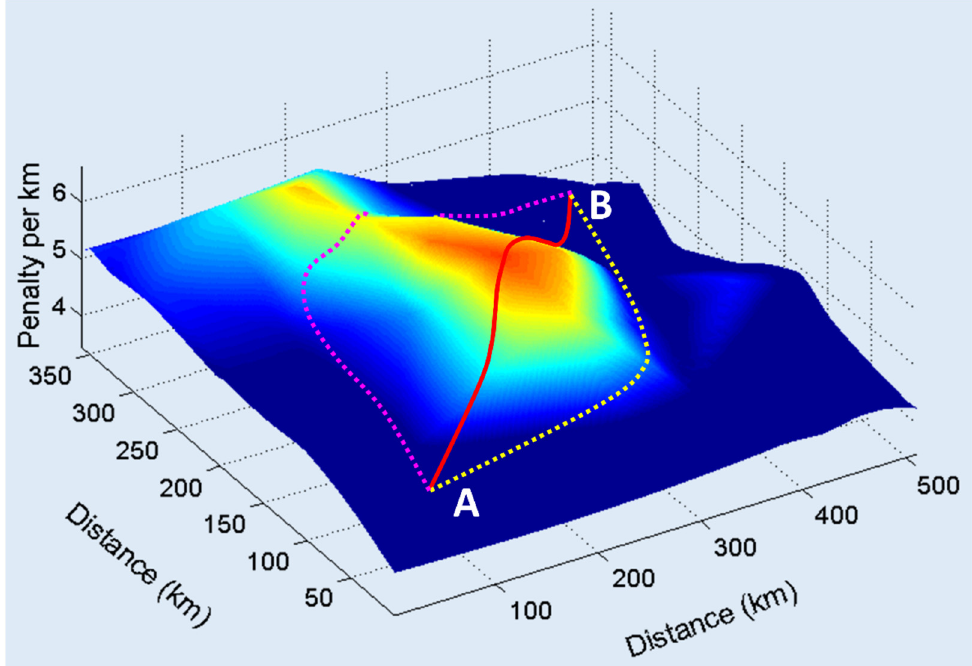
Figure 38. An example of optimum ship routing. The great circle route between two locations A and B on opposite sides of a storm is shown in red, while two more efficient routes are shown in magenta and yellow, though only the magenta route satisfied all constraints.